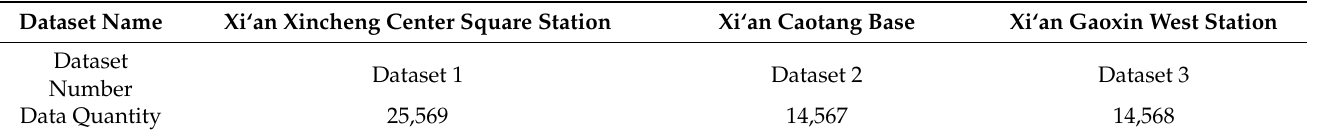
Table 4. The quantity of data in three datasets.